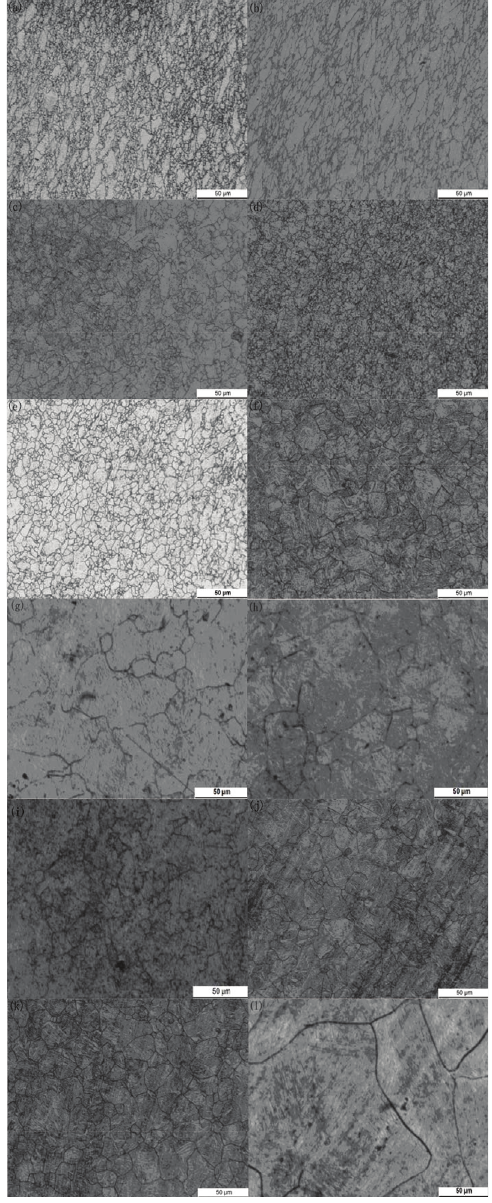
Figure 2: Microstructure of A-100 steel under different testing conditions: (a) 900°C − 0.01 s − 1 ; (b) 900°C − 1 s − 1 ; (c) 1,000°C